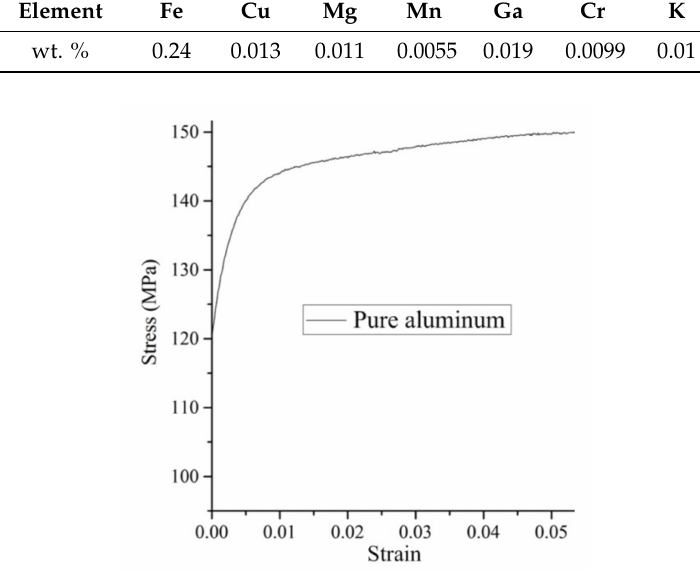
Figure 3. Stress-strain